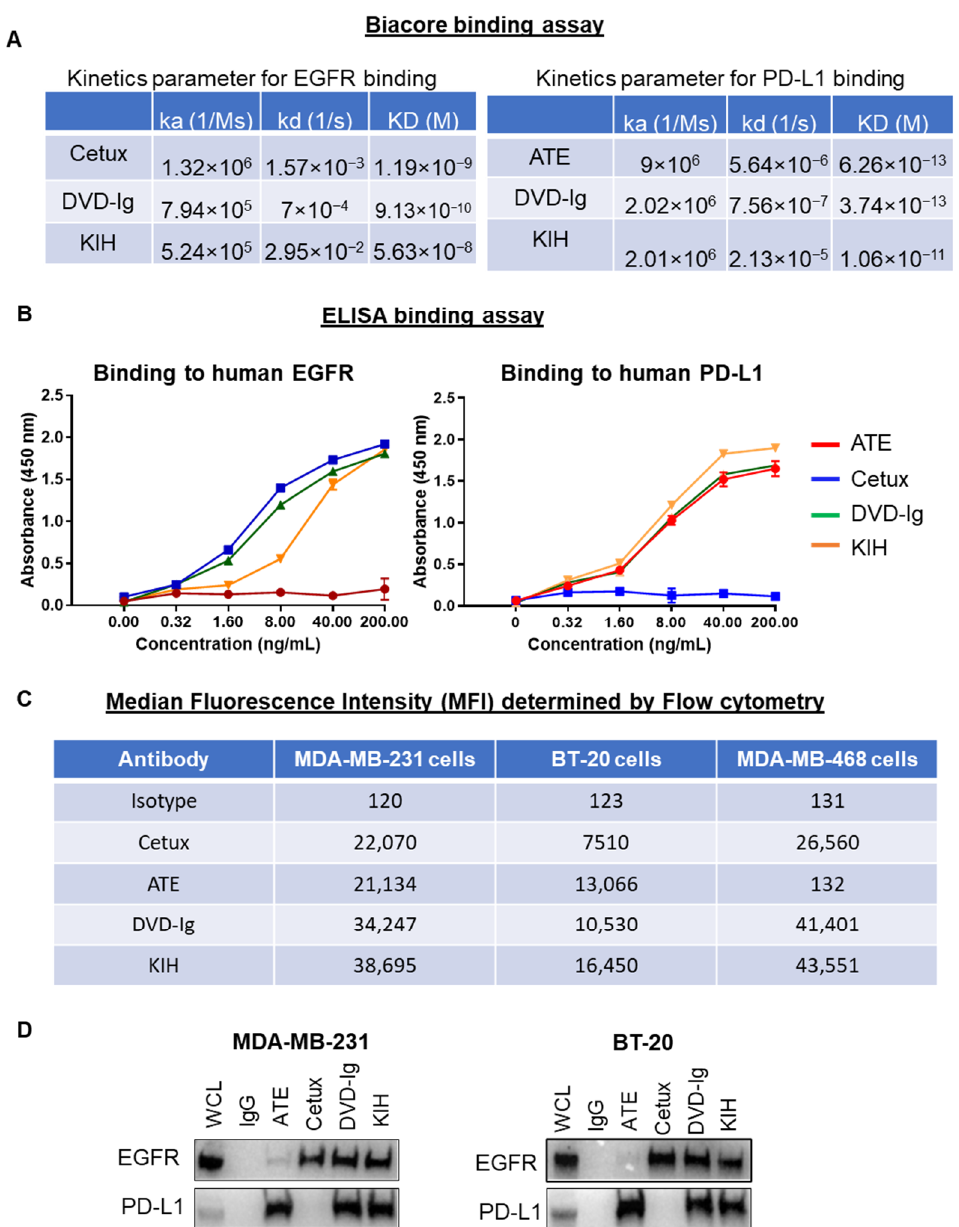
Figure 2. Binding activities of anti-EGFR/PD-L1 BsAbs: ( A ) Binding kinetics parameters of mAbs and BsAbs to PD-L1 and EGFR antigens as detected by a Biacore T200 optical biosensor instrument. ( B ) Dose-dependent binding activity of mAbs and BsAbs using ELISA binding assay showing that anti-EGFR/PD-L1 BsAbs bind to both EGFR and PD-L1 comparable with parental mAbs. ( C ) Binding profile of anti-EGFR/PD-L1 BsAbs and parental mAbs with cell surface EGFR and PD-L1 expressed on MDA-MB-231, BT-20, MDA-MB-468 cells was determined by flow cytometry analysis. Antibody concentration used in this experiment was 1 µ g per 1 million cells in 100 µ L volume of FACS buffer (1% FBS in PBS). Median florescence intensity (MFI) obtained from flow cytometric staining analysis was presented in tabular format. Human IgG was used as isotype control. ( D ) Coimmunoprecipitation assay using whole-cell lysate of MDA-MB-231 and BT-20 cells to assess the binding of anti-EGFR/PD- L1 BsAbs and parentals mAbs with EGFR and PD-L1. Unprocessed western blots images of Figure 2D are provided in Supplementary Figure